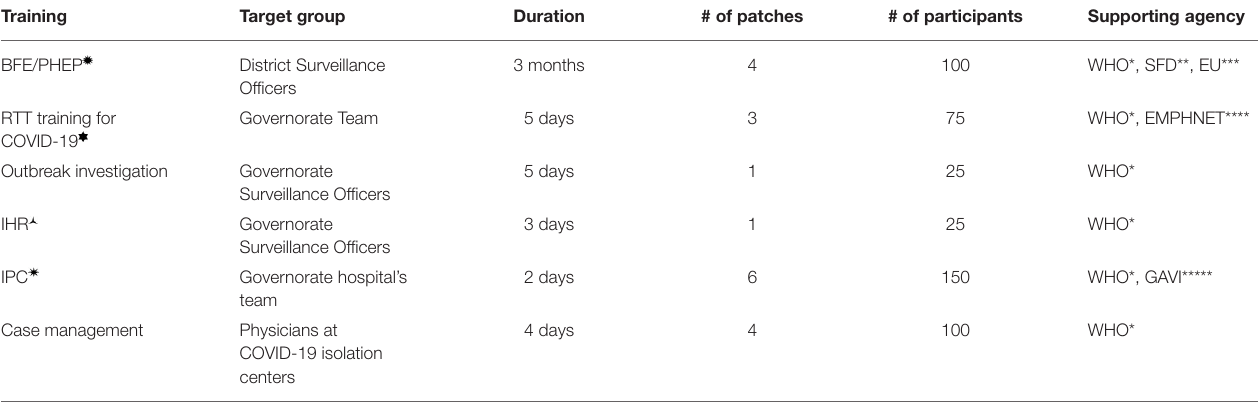
TABLE 2 | Yemen Field Epidemiology Training Program participation on building the health workforce capacity on COVID-19, Yemen, 2020-2021.